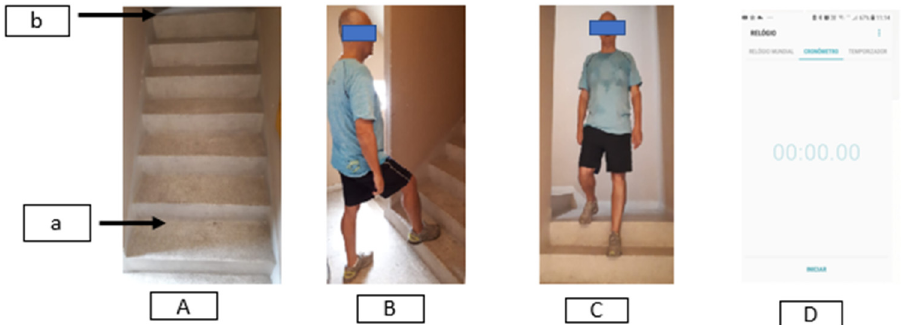
Figure 3. Environmental conditions for the individual to perform the SCT. ( A ) the stair and the arrows indicate in (a) is the first step and in (b) the last step; ( B ) the movement to climb the stair, ( C ) the movement to descend the stair, and ( D ) a timer, that could be a chronometer or a watch.